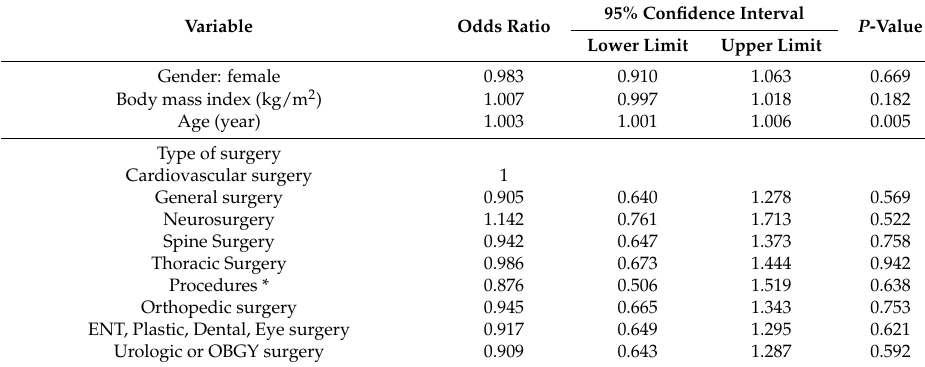
Table A2. Univariate logistic regression analysis for all-cause one-year mortality after